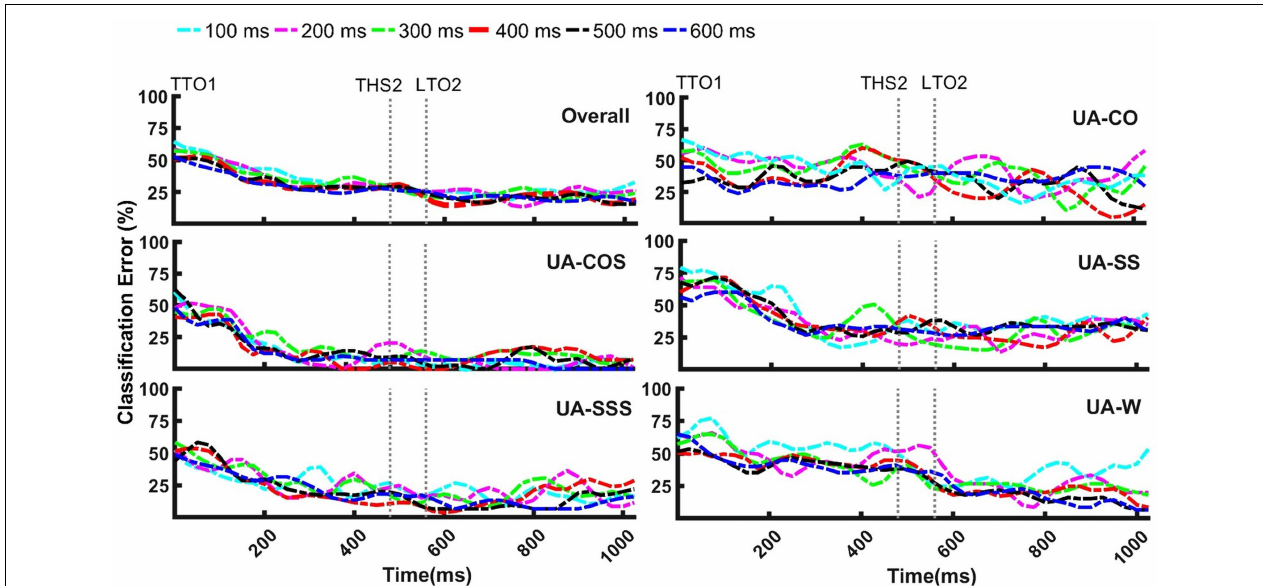
FIGURE 5 | The influence of varying analysis window size on recognition of unanticipated straight walking (UA-W), cuts (UA-CO, UA-SS), and cuts to stair ascent (UA-COS, UA-SSS) over time. Highly overlapping patterns were observed for different window sizes within each locomotion mode. To execute cut, subjects started the transition at the first trailing leg toe off (TTO1) and ended with the second trailing leg heel strike (THS2). LTO2 stands for the second leading leg toe off. Events are the average across subjects. X -axis data was shown up to the length of the shortest trial.